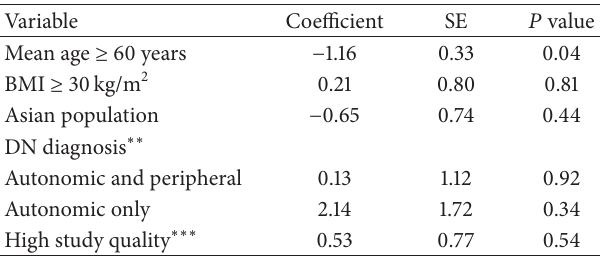
Table 2: Univariate meta-regression analysis of risk of SAS related to study characteristics ∗